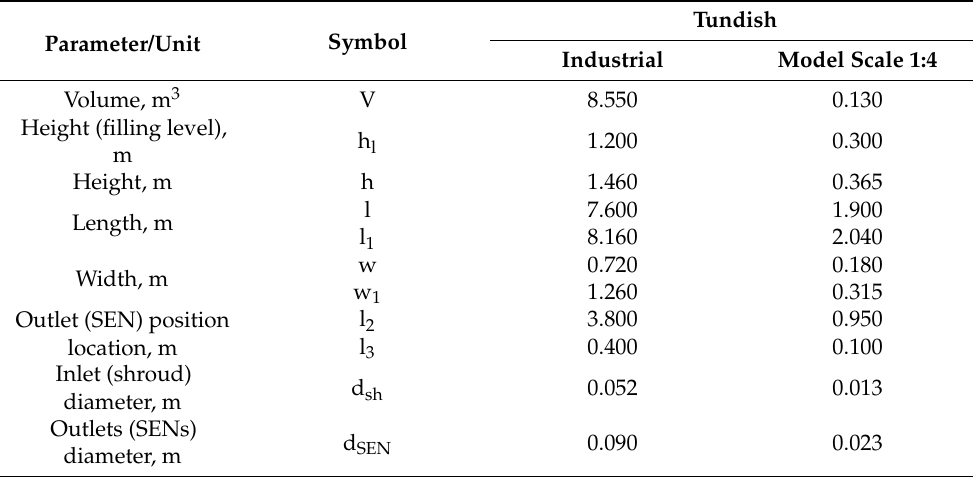
Table 1. Design data for the industrial and the model